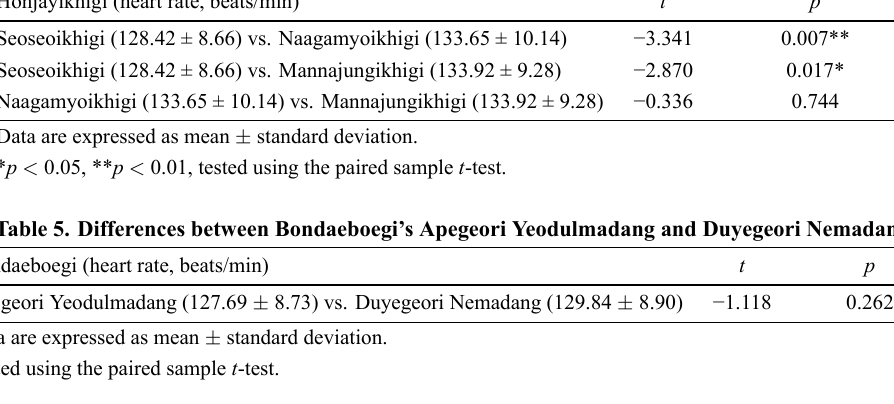
Table 4. Differences among Honjayikhigi’s Seoseoikhigi, Naagamyoikhigi, and Mannajungikhigi. Honjayikhigi (heart rate, beats/min) t p